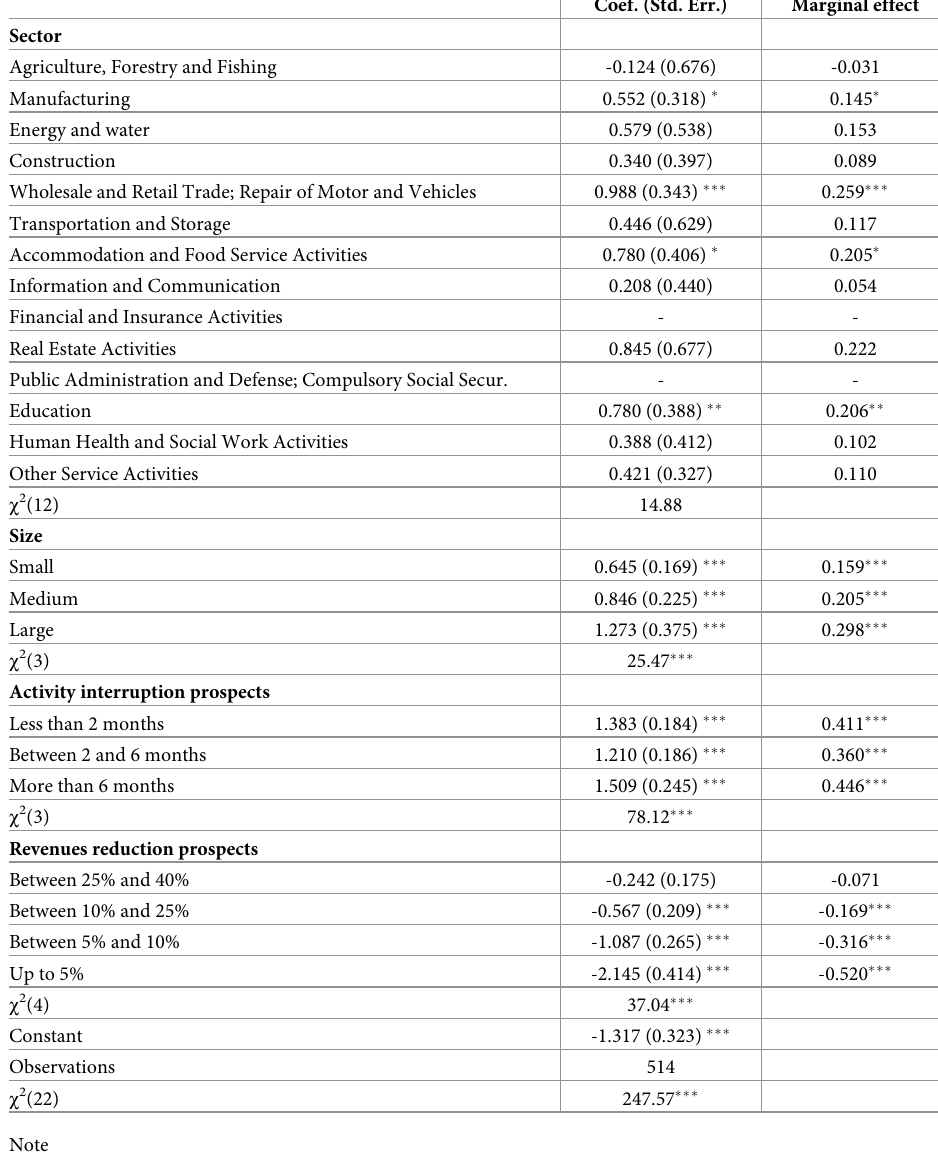
Table 4. Probit model on the decision to take